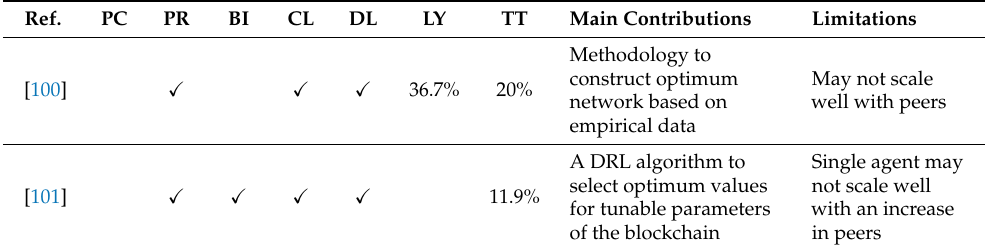
Table 9. Comparison of Multi-Layer Techniques. PC = Public Blockchain, PR = Private Blockchain, BI = Blockchain-IoT, CL=ConsensusLayer, DL=DataLayer, LY=Latency, TT=TransactionalThroughput.